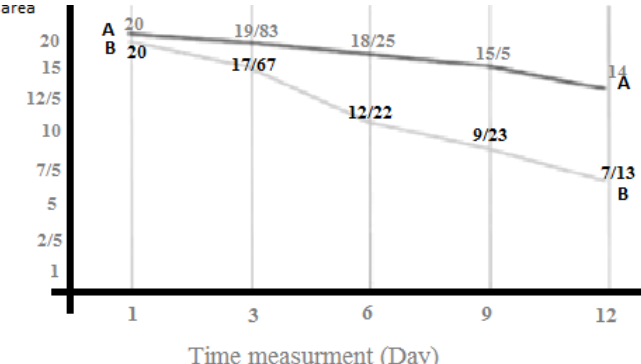
Figure6: (A) Creating superficial burns with UV rays, (B) Rat dressed, (C) Burn recovery with burn dressing